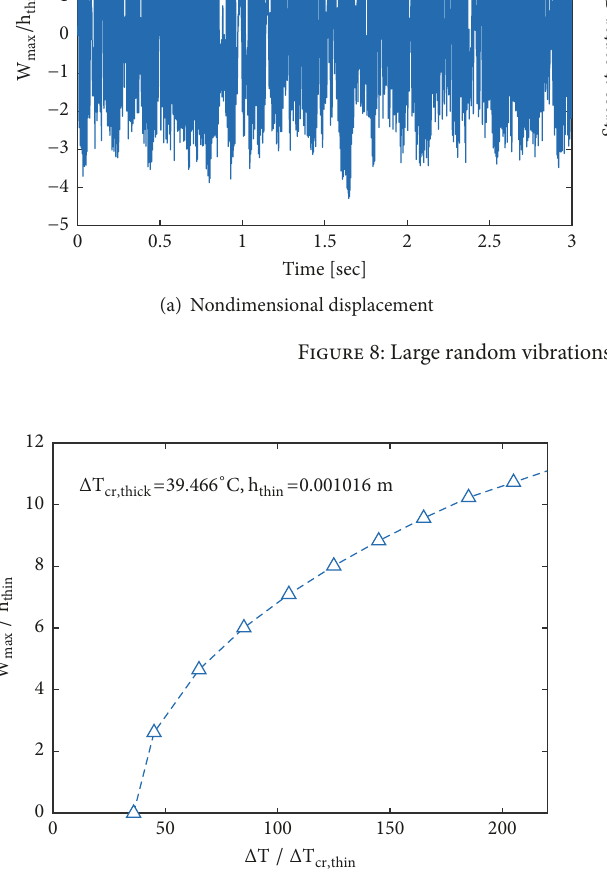
Figure 9: Thermal postbuckling response (a/h =